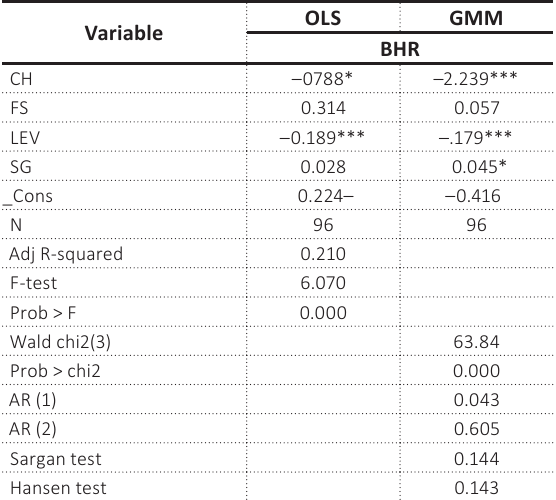
Table 6. Regression